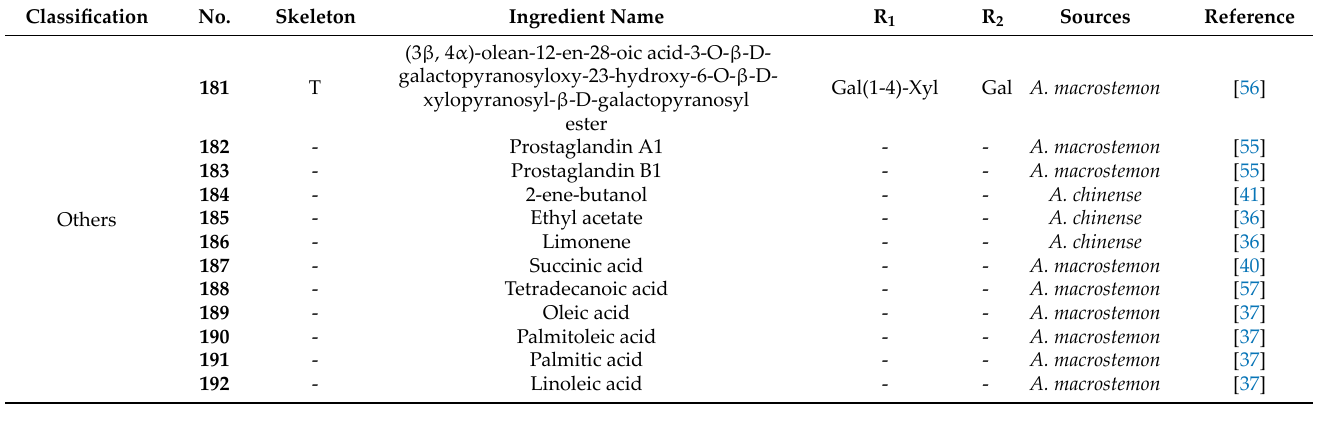
Table 8. List of other compounds isolated from AMB.